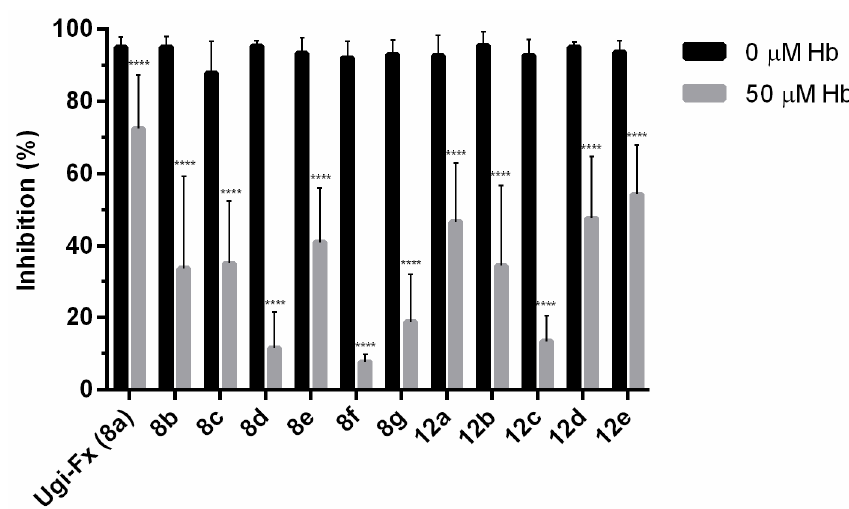
Figure 4. Effects of hemoglobin (Hb) on the antiproliferative effect of selected · NO-donor compounds. The results are expressed as the percentage of cell growth inhibition relative to the control cells. The data are the means ± SD obtained from three determinations. Statistical analysis: a two-way ANOVA followed by a Bonferroni multiple comparison test: **** p < 0.0001.